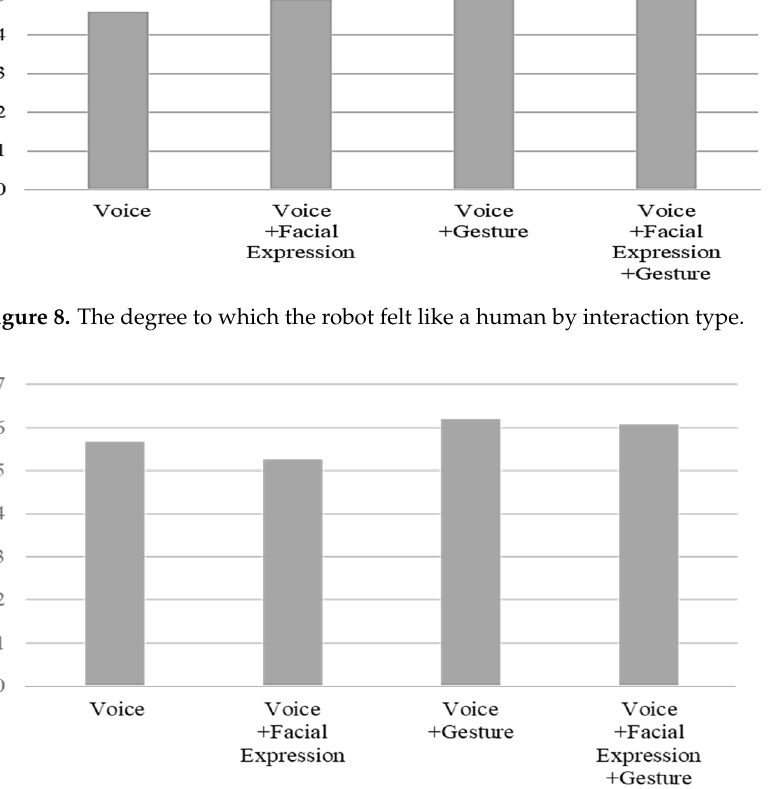
Figure 9. Degree to which the participants felt familiar with the robot by interaction type.